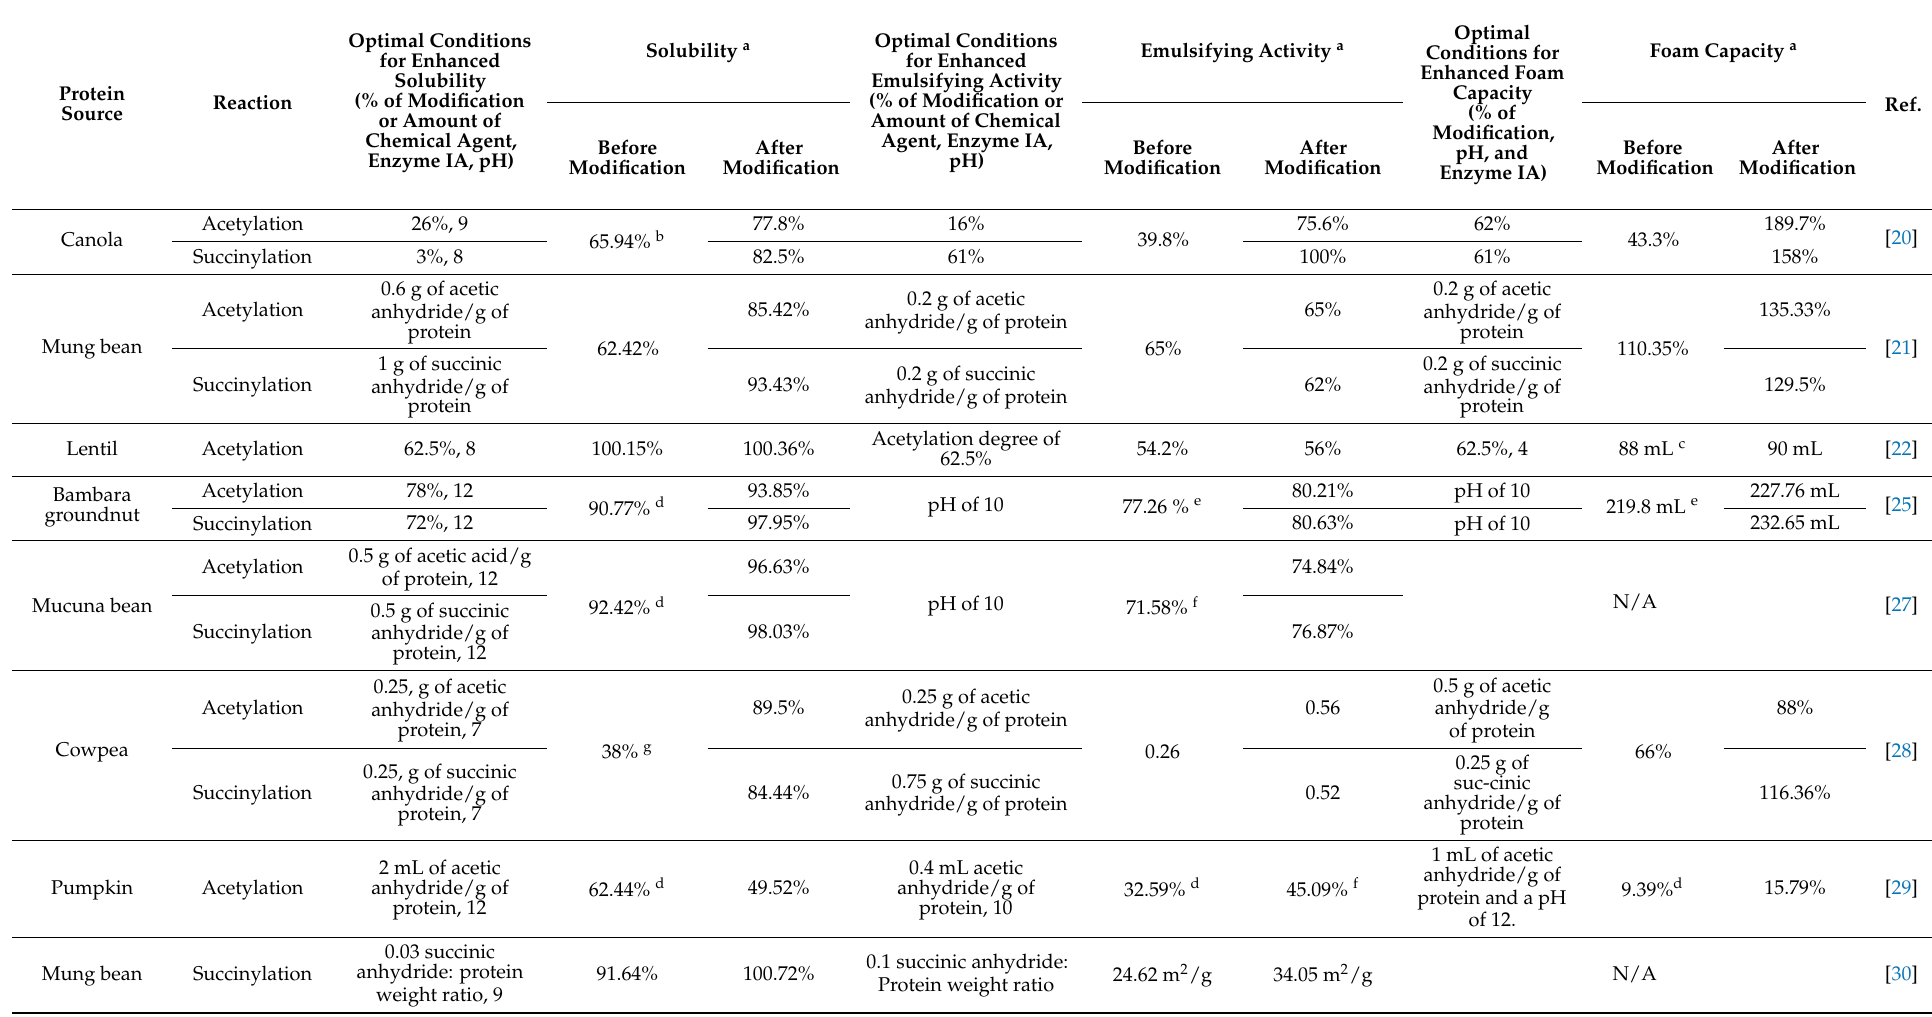
Table 1. Previous works on acetylation, succinylation, and hydrolysis of plant-based proteins and their functional properties